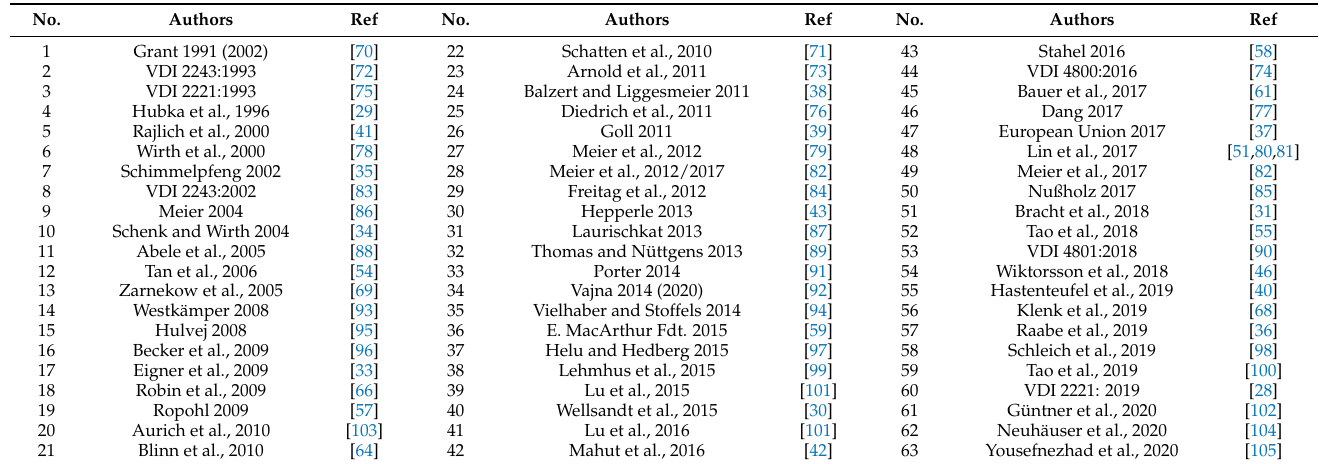
Table 3. Chronological listing of lifecycle identified in